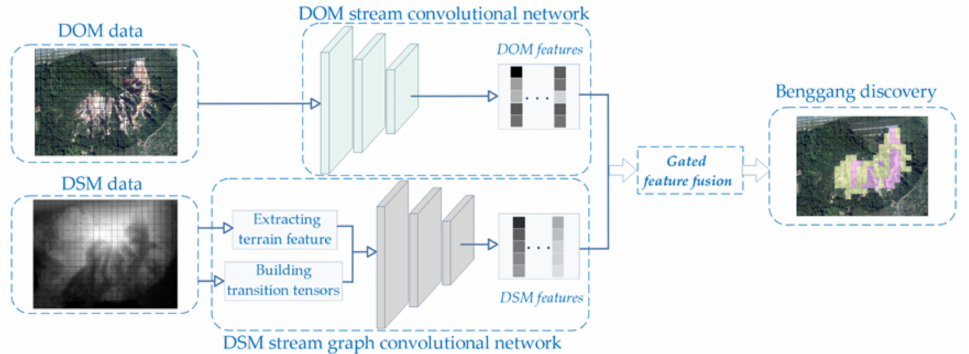
Figure 3. The proposed benggang discovery